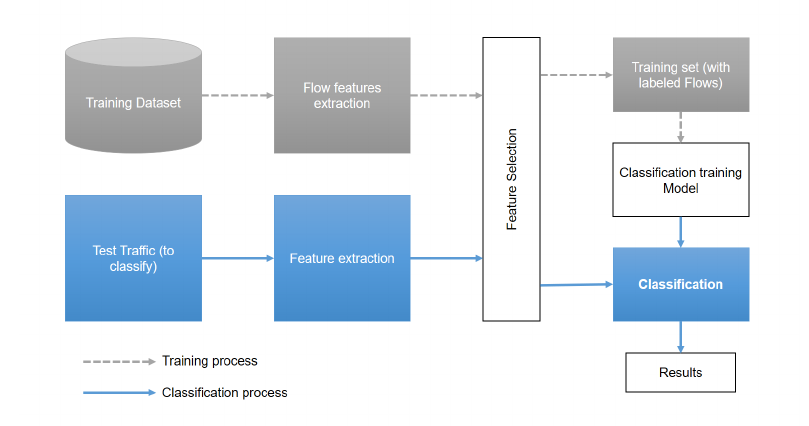
Figure 5. Training and classification